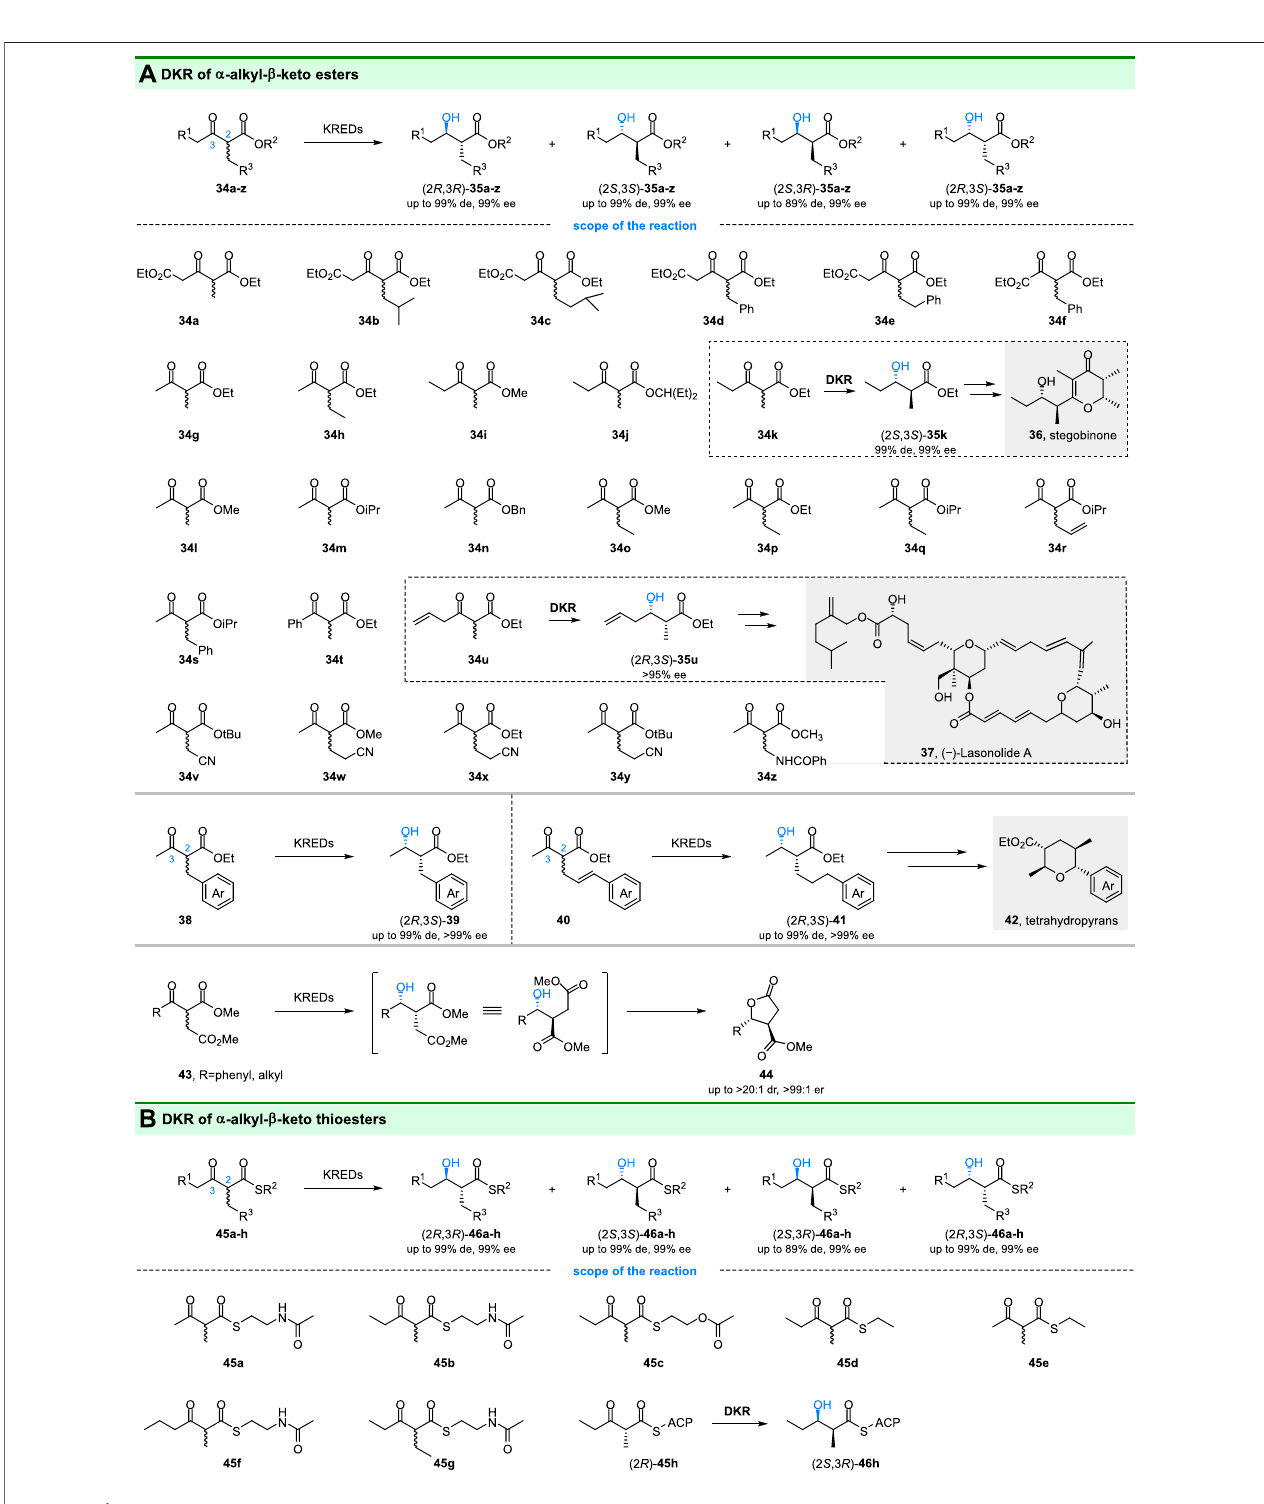
FIGURE 7 | DKR of (A) α -alkyl- β -keto esters and (B) α -alkyl- β -thioesters esters.